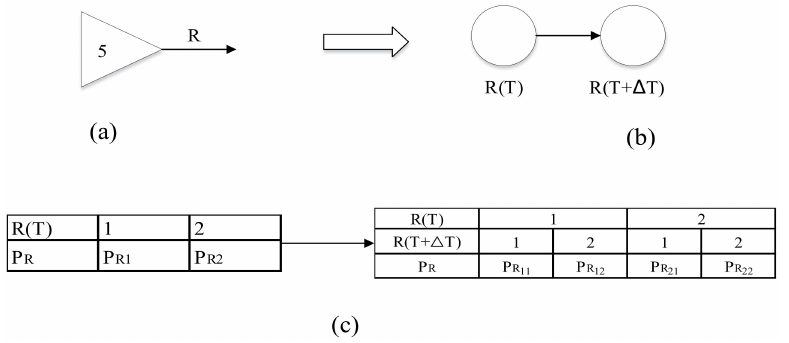
Figure 7. The dynamic Bayesian network corresponding to operator 5. ( a ) is the operator 5, ( b ) is the corresponding initial network and transition network, and ( c ) is the conditional probability table of each